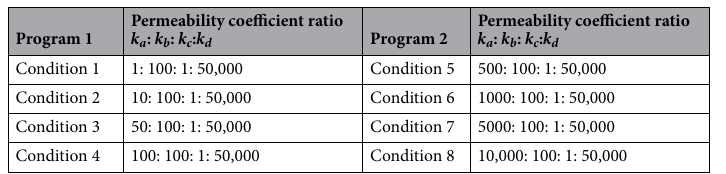
Table 5. Tailings permeability coefficient ratios between each